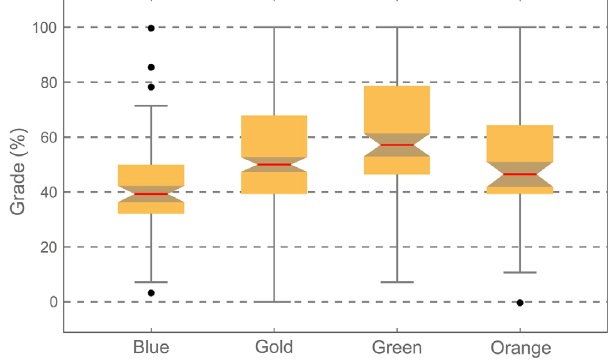
FIG. 5. Box plots of grades on test 1 for different personality types.